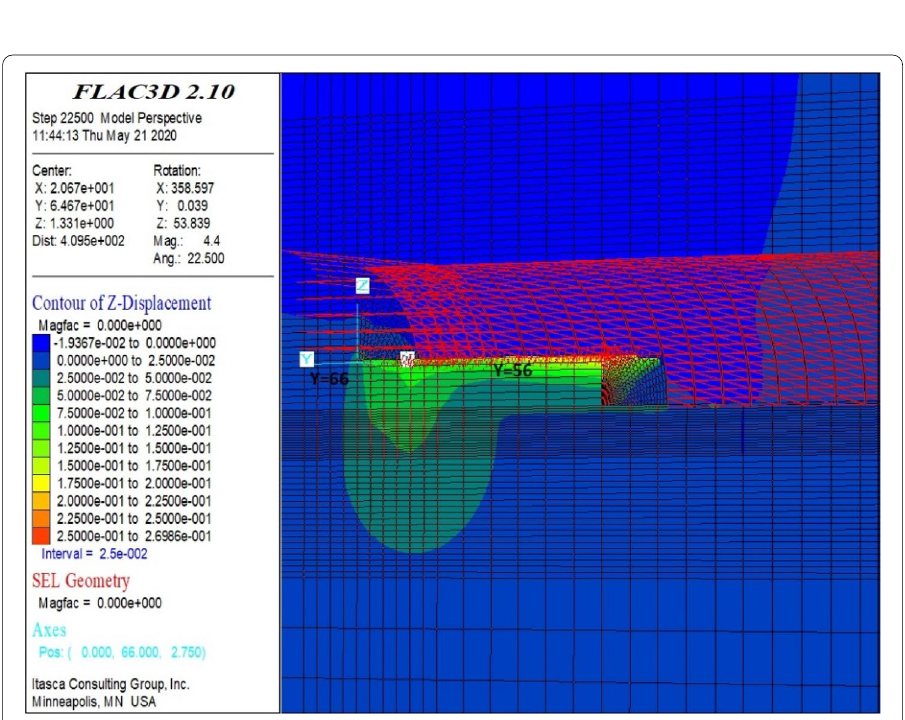
Fig. 23 Swelling at the top heading section in the Z direction (with umbrella and